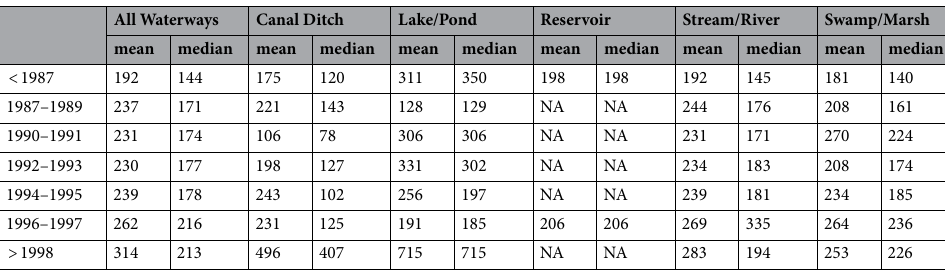
Table 1. Temporal average and median of nearest distance (m) of swine waste lagoons to water features. NA indicated that the water feature was not the closest waterway to any of the studied swine waste lagoons for the time period.